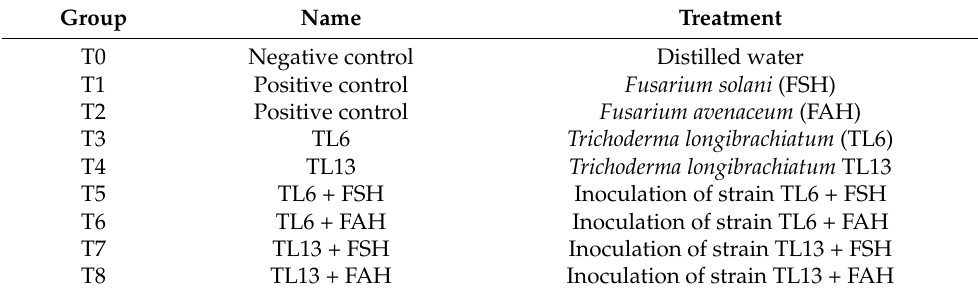
Table 1. Description of